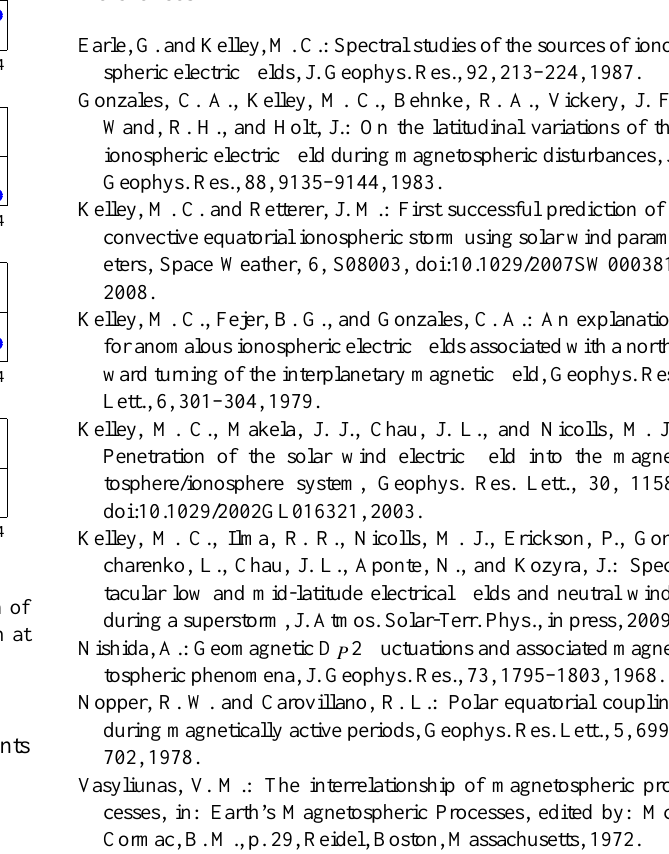
correlation at other local times. Note that these statements are equally valid for B z south and